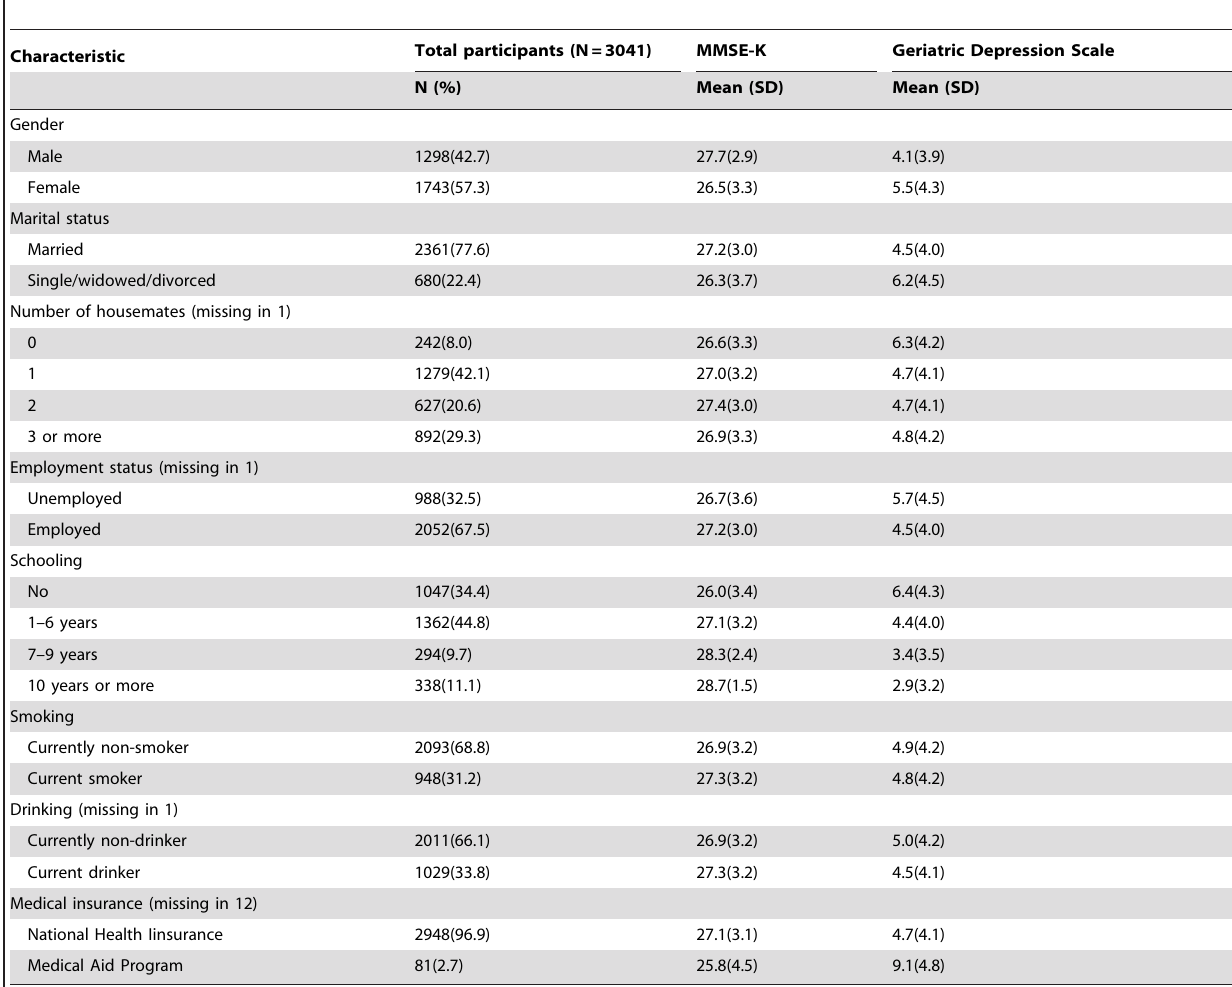
Table 1. Basic characteristics study participants and scores of the Korean version of Mini-Mental State Examination (MMSE-K) and Geriatric Depression